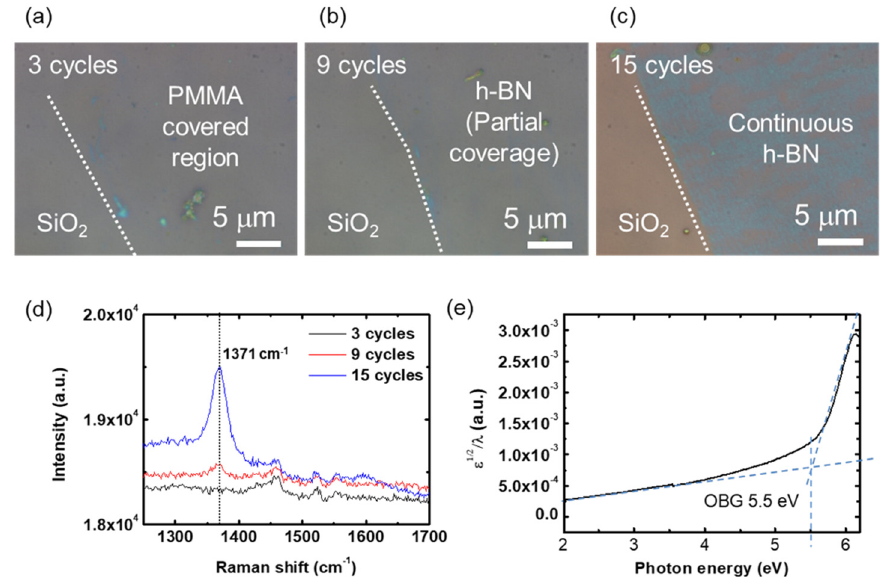
Figure 2. Synthesis of h-BN layers and its physical properties. ( a – c ) Optical microscope images of the transferred h-BN films on SiO 2 /Si substrates grown for ( a ) 3 cycles, ( b ) 9 cycles, and ( c ) 15 cycles. ( d ) Raman spectra of the h-BN films in ( a – c ). ( e ) Tauc’s plot of the UV-Vis spectrum of the synthesized h-BN film.